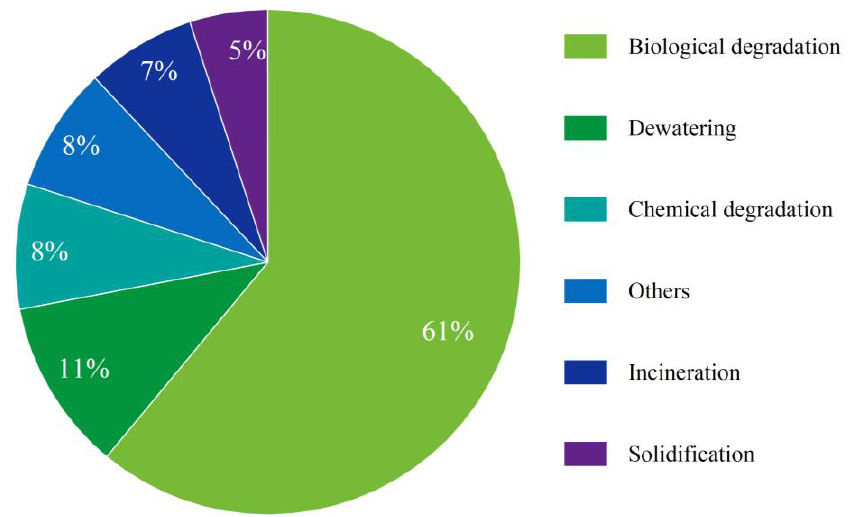
Figure 4. A pie chart showing the percent share of journal articles dealing with different harmfulness reduction treatment methods.